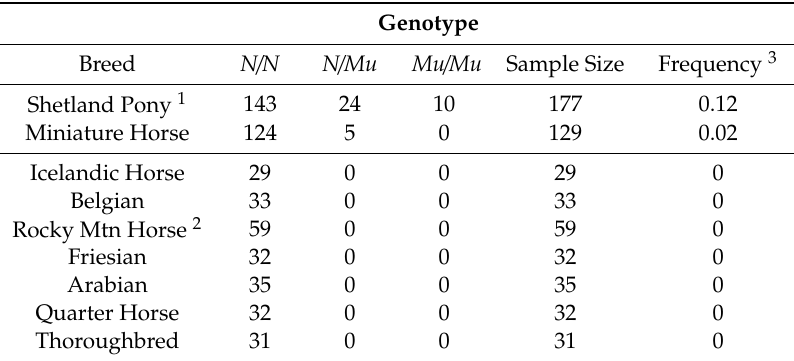
Table 4. Allele frequencies for MFSD12 c.600dupC. Eight additional breeds as well as a random sample set of Shetland Ponies were screened for the causal mushroom variant and allele frequencies are reported